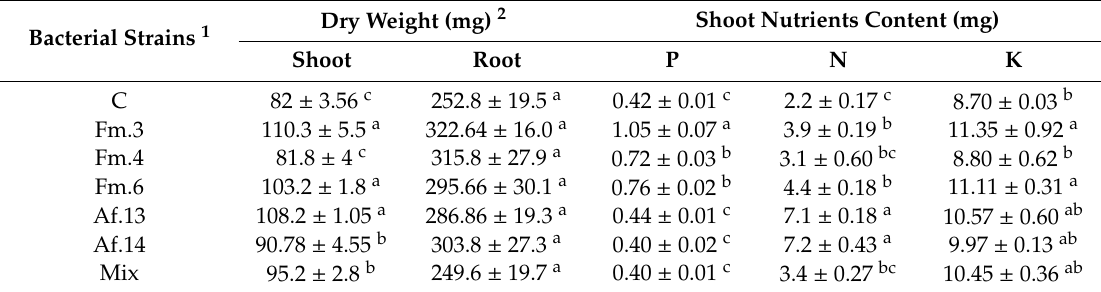
1 C: controls without bacterial inoculation. Identity of the bacterial isolates is available in Table 2. Mix, bacterial consortium consists of Fm.3, Fm.4, Fm.6, Af.13, and Af.14. 2 Di ff erent letters between columns denote that mean values are significantly di ff erent ( p ≤ 0.05) by Tukey’s test, means ± SE ( n = 5). Inoculation of maize plants with Bacillus spp. Fm.3, Fm.4, and Fm.6 significantly (F6,14 =